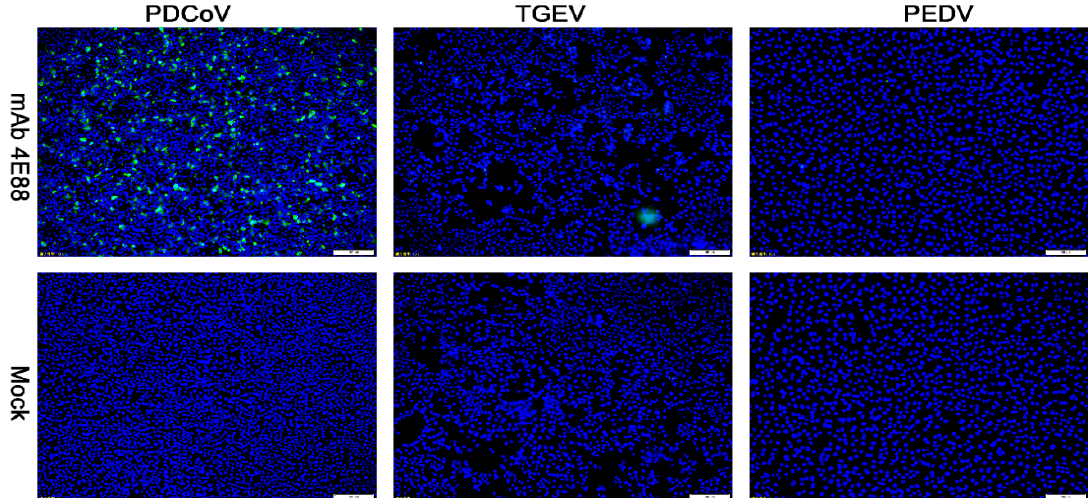
Figure 5. Reactivity of mAb 4E88 with PDCoV, TGEV, and PEDV-infected cells determined by IFA. Binding was visualized with FITC labeled goat anti-mouse antibody, while DAPI was used to visualize the cell nuclei. The strain used for cell infection is shown at the top, and the antibody used for the assay are indicated on the left. Magnification = 10 ×